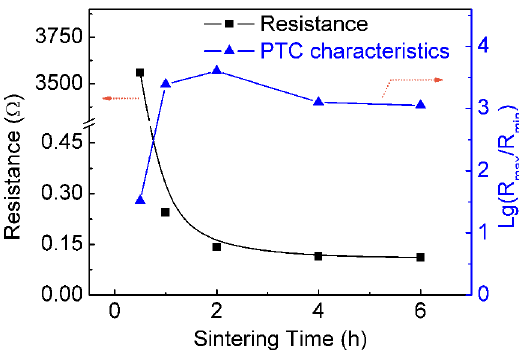
Figure 2. The room-temperature resistance and the jumping ratio are as a function of the sintering time. In addition, the relative densities of the ceramics increased with the sintering time (Figure 3). The S1 and S5 samples showed relative densities of 79.8 and 91.0%, respectively.